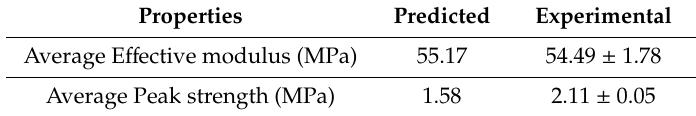
Table 4. Compressive properties of Kagome structures fabricated by fused deposition